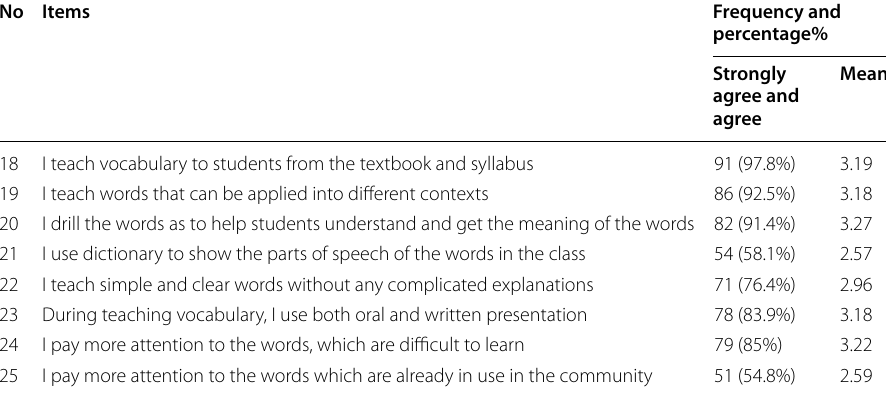
Table 5 Teachers’ perception of use of different techniques of teaching vocabulary No